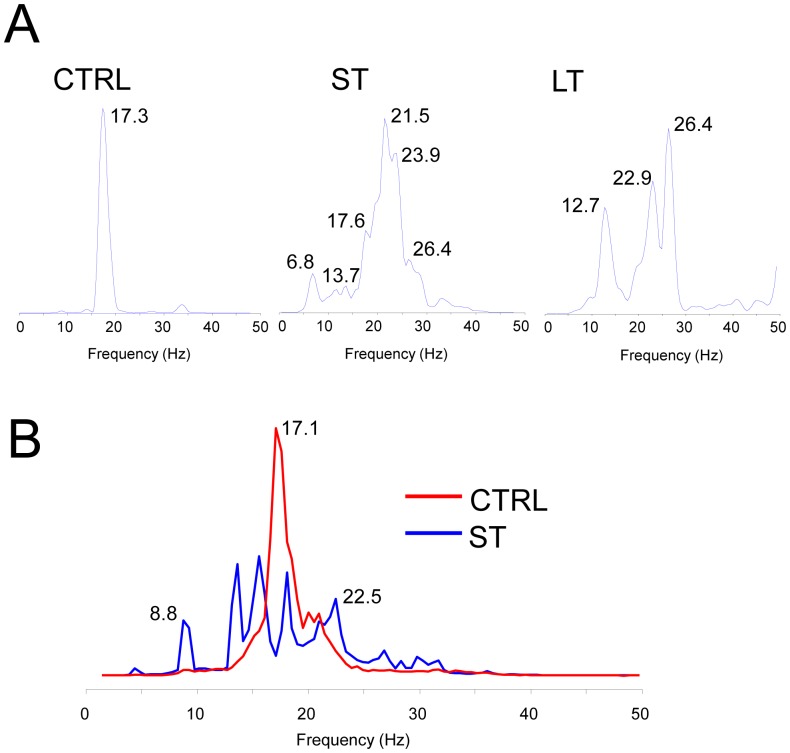
Welch power spectra.A. Welch averaged 10 consecutive power spectra of single animals from the CTRL (left), ST (middle) and LT (right) groups. B. Averaged power spectra of 1-second long pseudo-ECG segments for 93 VF events lasting more than 2 seconds in the CTRL (red) group and for 29 VF events lasting more than 2 seconds in the ST (blue) group (This analysis was not performed for the LT group because only 5 VF events in 4/7 animals were detected in that group).